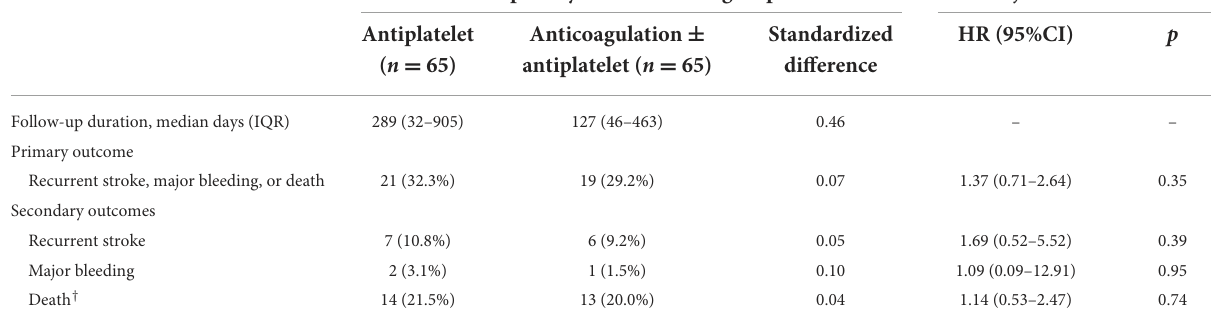
TABLE 2 Primary and secondary outcomes from the intention-to-treat analysis by